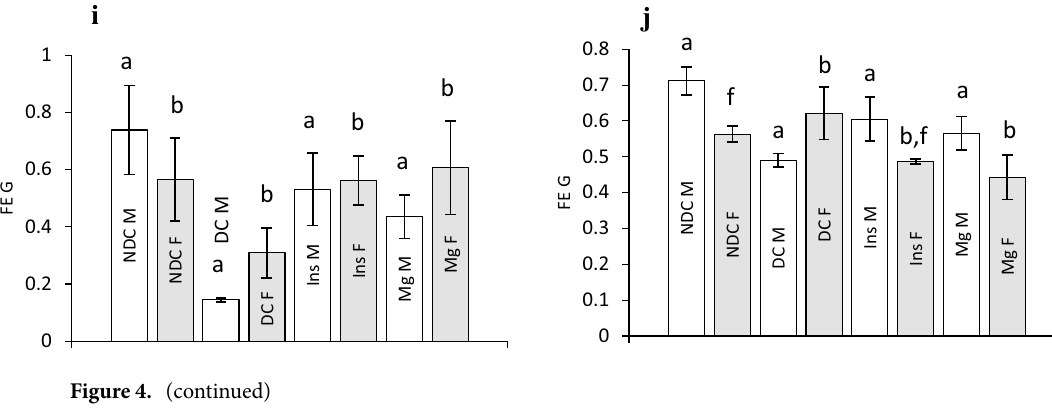
(Fig. 4h). Diabetes induction significantly (male: p < 0.0001, female p < 0.001) decreased FE Na in both DC parents in compared to NDC groups. However, insulin therapy only increased FE Na in female parent in compared to diabetic female parent ( p < 0.001), but Mg therapy increased FE Na in both parents in compared to both diabetic parents (male: p < 0.0001, female p < 0.001). Our results also showed that FE Na in male offspring of diabetic parents significantly decreased in compared to male offspring of NDC parents ( p < 0.0001). Insulin or Mg therapy in diabetic parents could not have any effect on FE Na in their offspring. The results of the present study showed that FE G in both parents significantly (mail: p < 0.0001, female p < 0.001) decreased after diabetes induction and Mg or insulin administration could significantly increase FE G in both sexes (male: p < 0.0001, female: p < 0.001,